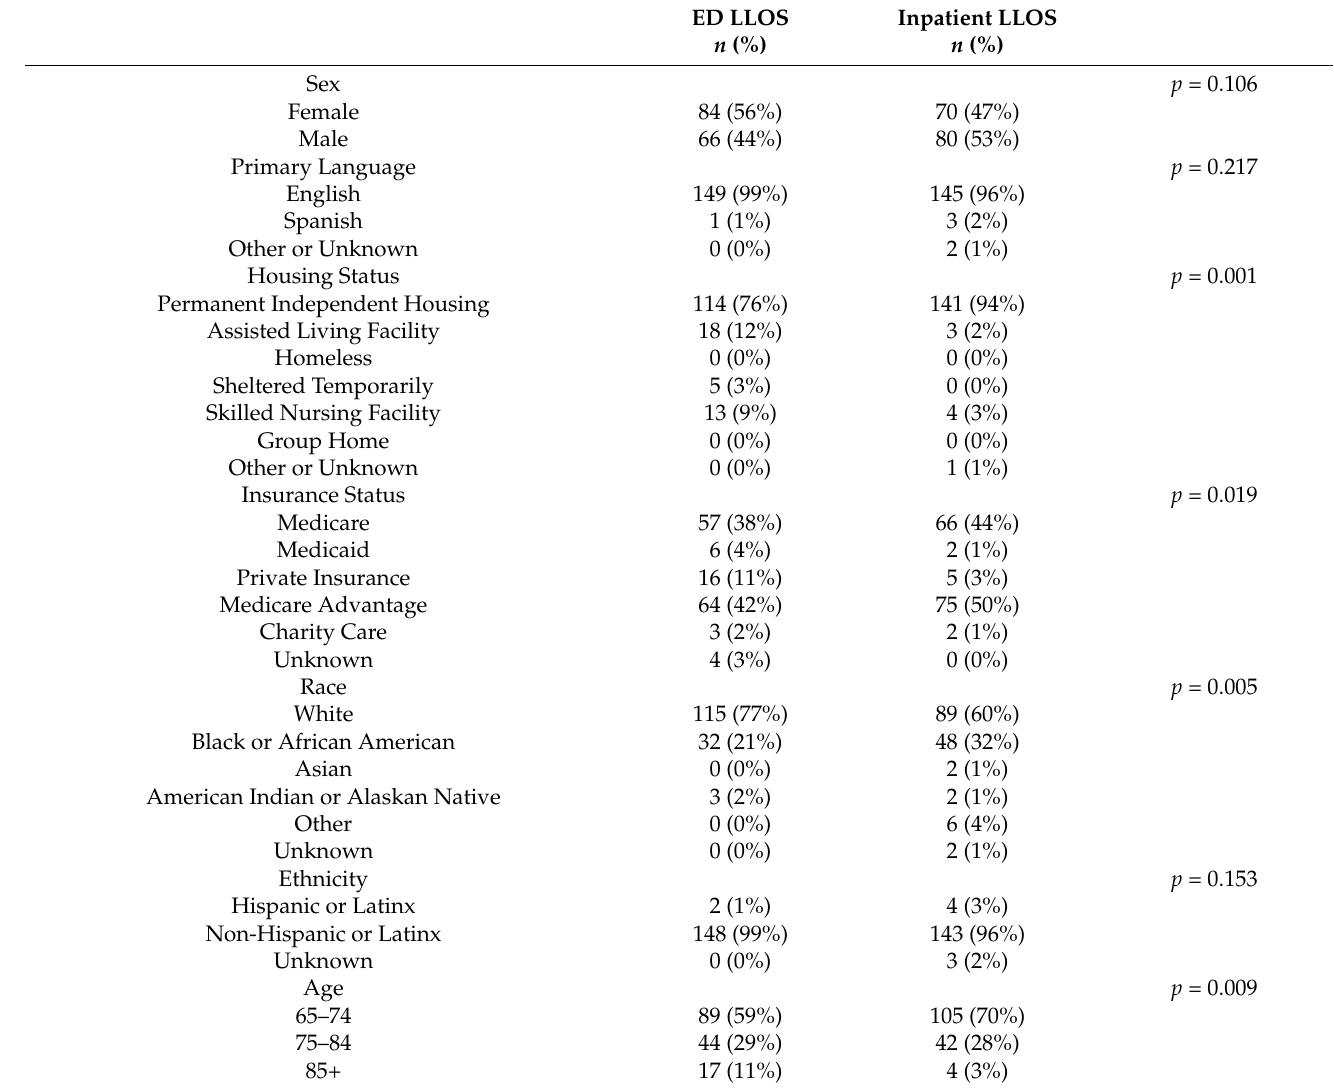
Table 1. Demographic Makeup of ED and inpatient LLOS